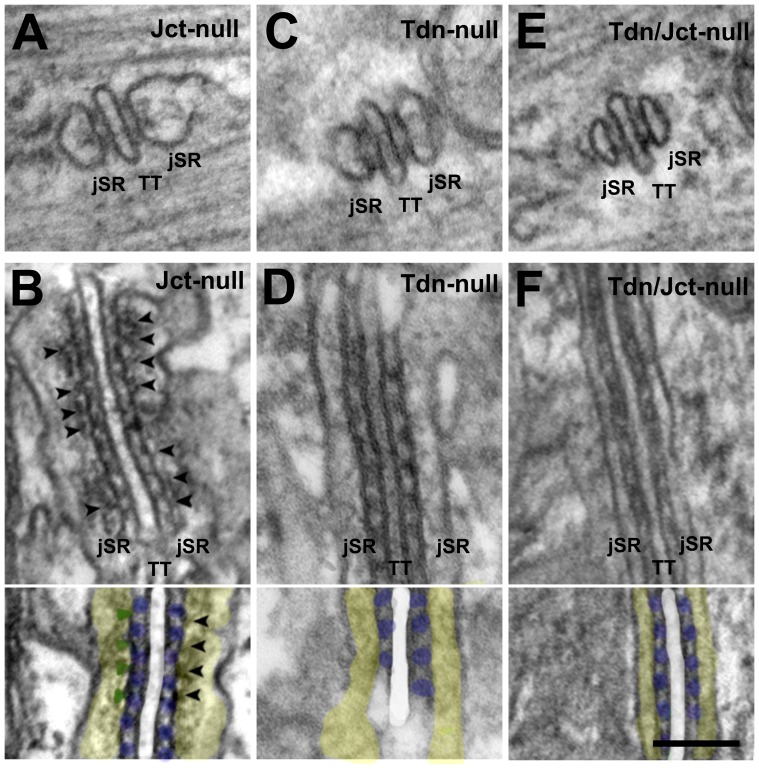
Sections from sternomastoid muscle in mutated mice.A and B) In the absence of Jct the overall structure is not visibly altered. A polymer of CASQ fills the jSR and is anchored to the feet-bearing jSR membrane (arrowheads). The size of the transversely cut jSR profiles is slightly smaller than wild type in this image (see detail in Fig. 4C and D). In the absence of Tdn anchors are missing and the visible jSR content quite reduced although still visible. The jSR cisternae are considerably smaller. E and F) In the double mutant, the jSR profiles are very narrow and they seem to be basically empty. In all cases, the jSR-T tubule junctional gap and the rows of feet are unaltered. Colors: white: T-Tubule; yellow: jSR lumen; blue RyRs; Green: anchors. Bar: A–F, 0.1 µm.